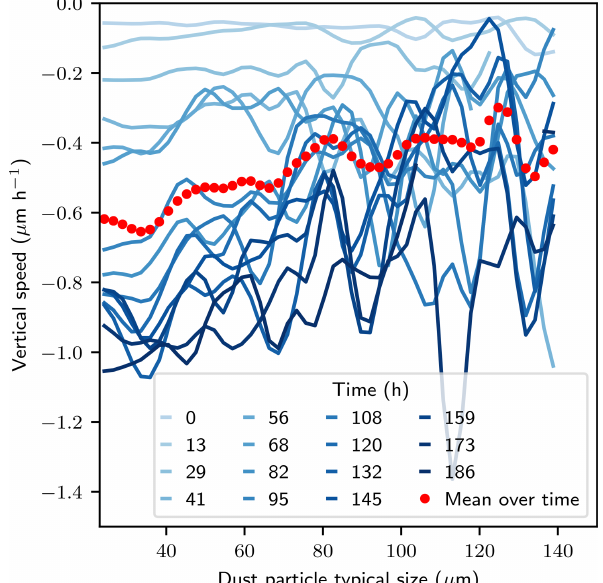
Figure A3. Mean vertical speed as a function of dust particle size for the temperature gradient experiment. Note that, here, only move- ments of type 1 and 2 and particles of volumes larger than 5 3 voxels were taken into